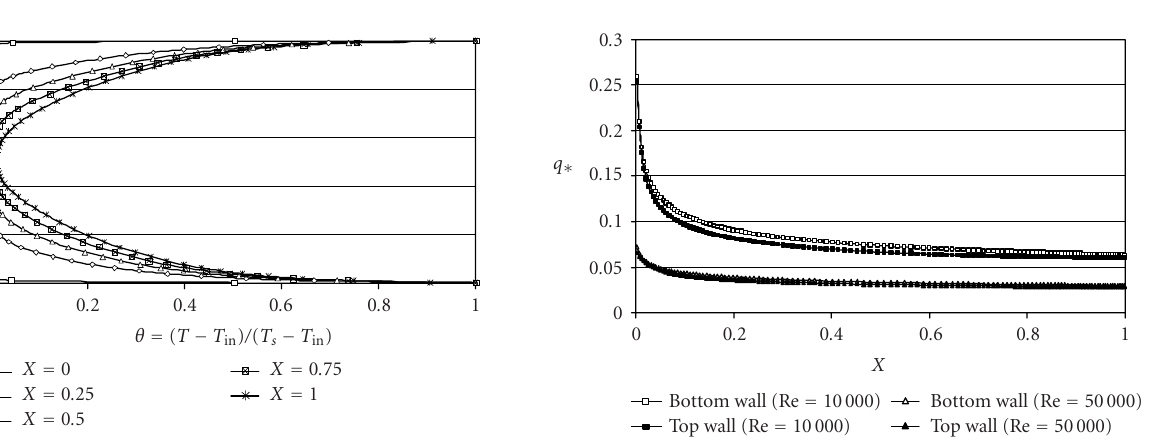
Figure 13: Nondimensional temperature distribution at di ff erent sections of the cooling channel for Re = 10000 and ˙ m r = 1 / 2.